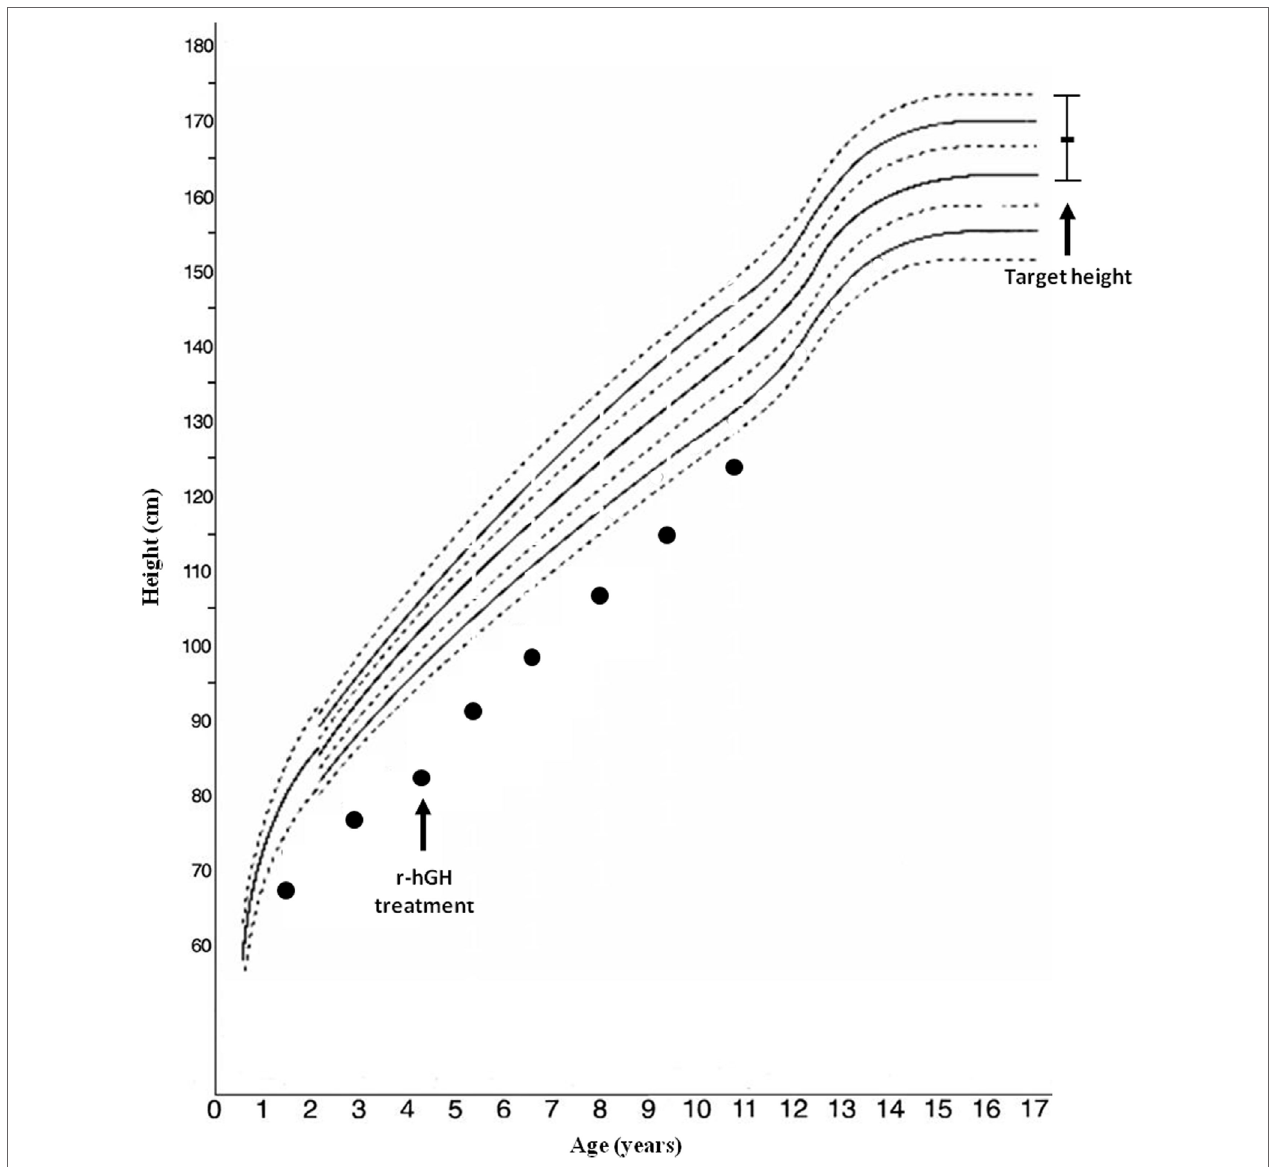
FIGURe 1 | Growth chart of the